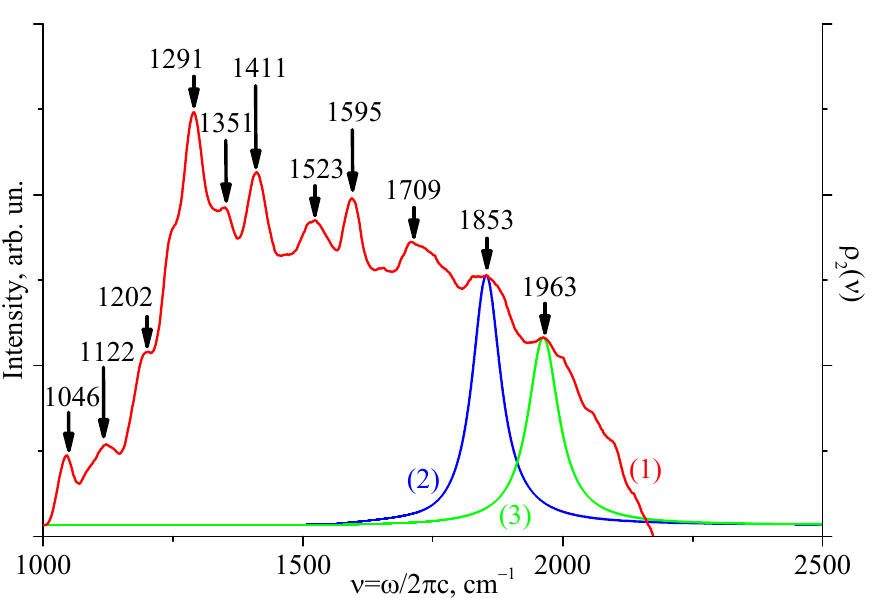
Figure 4. Raman scattering spectra of the crystal LiNbO 3 :Gd 3+ (0.003):Mg 2+ (0.65 wt.%) in the region of two ‐ phonon states: 1—experimental curve, 2 and 3—calculated dependences.